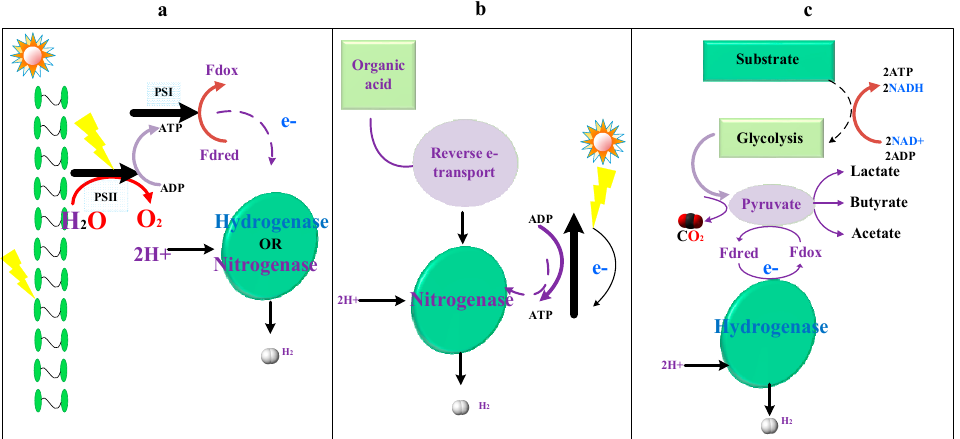
Figure 3. Conceptual illustration of the bio-hydrogen generation pathways: ( a ) biophotolysis, ( b ) photofermentation. ( c ) DF (dark fermentation), PSI represents photosynthesis system 1, PSII is photosynthesis system 2, Fdox is the oxidized Ferredoxin, and Fdred is the reduced Ferredoxin.